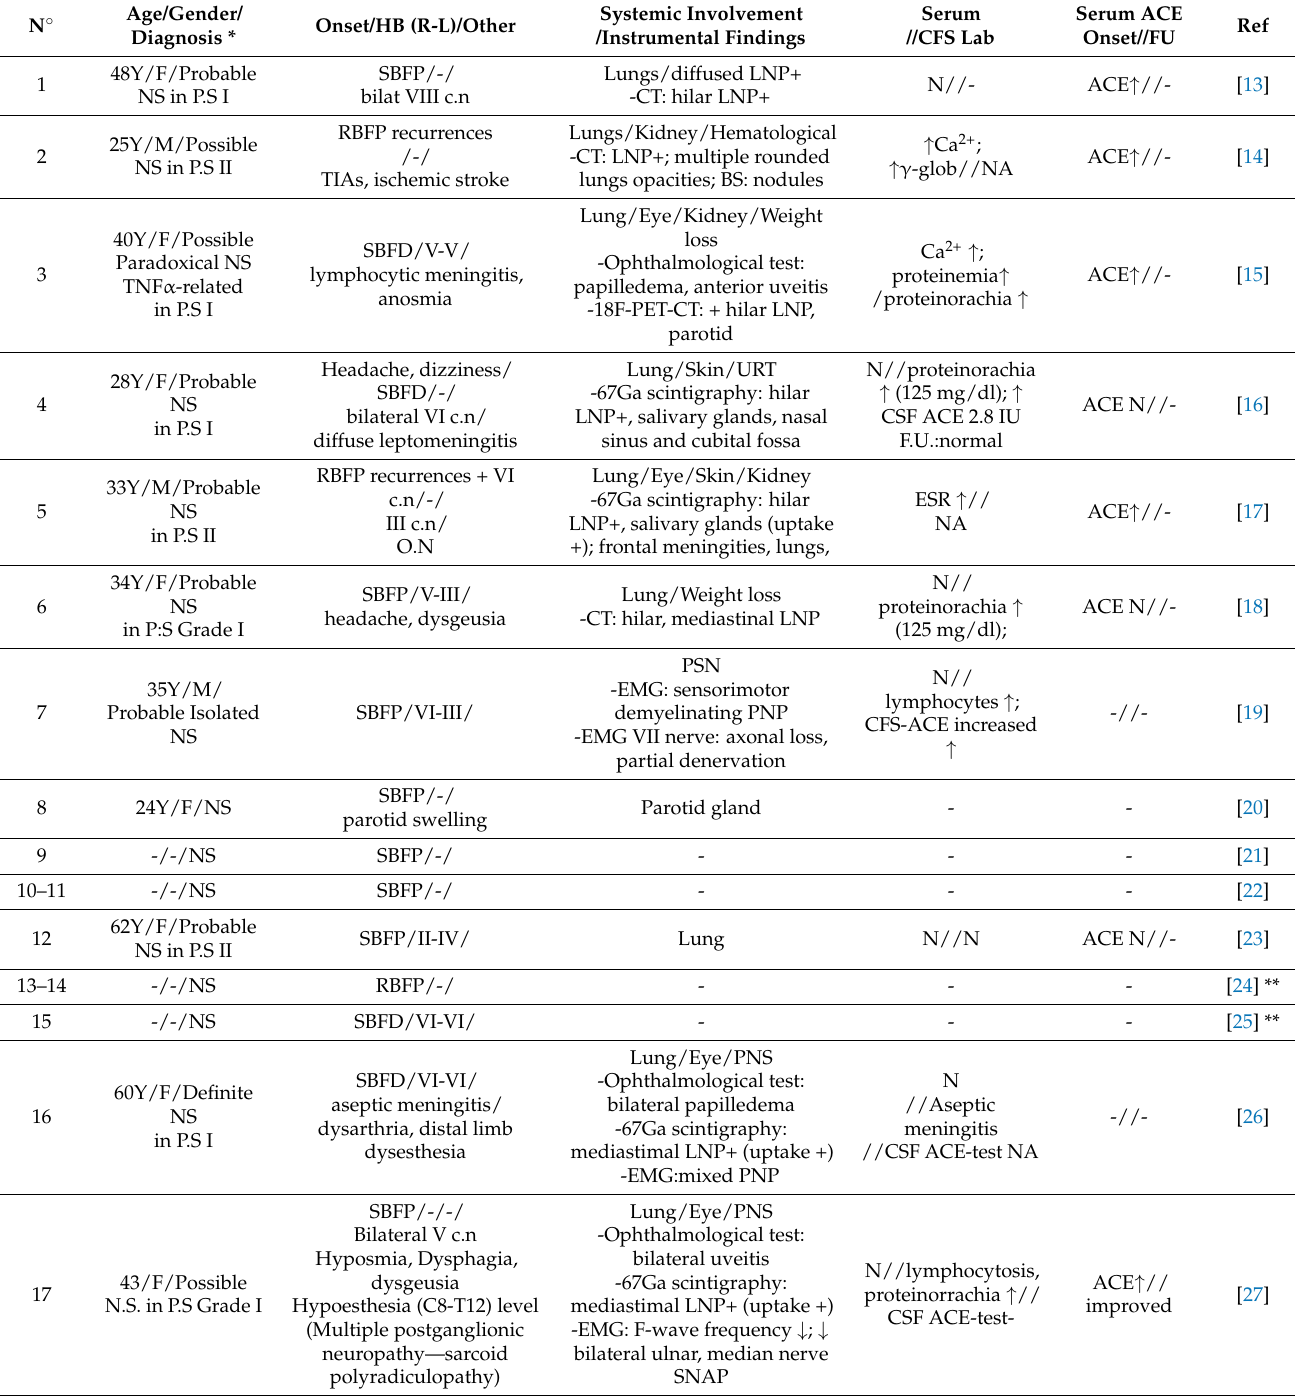
Table 1. Demographic and clinical properties of patients with bilateral facial palsy/plegia as the onset of NS (Heerfordt’s syndrome cases not